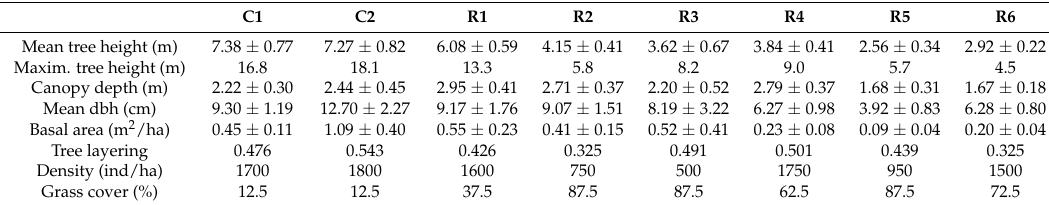
dbh: diameter at breast height, ind: individuals.